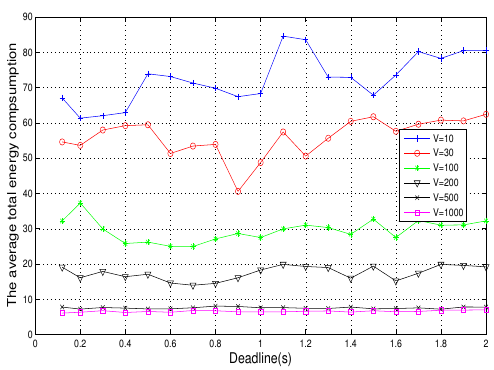
Figure 7. Average total energy consumption vs. deadline.